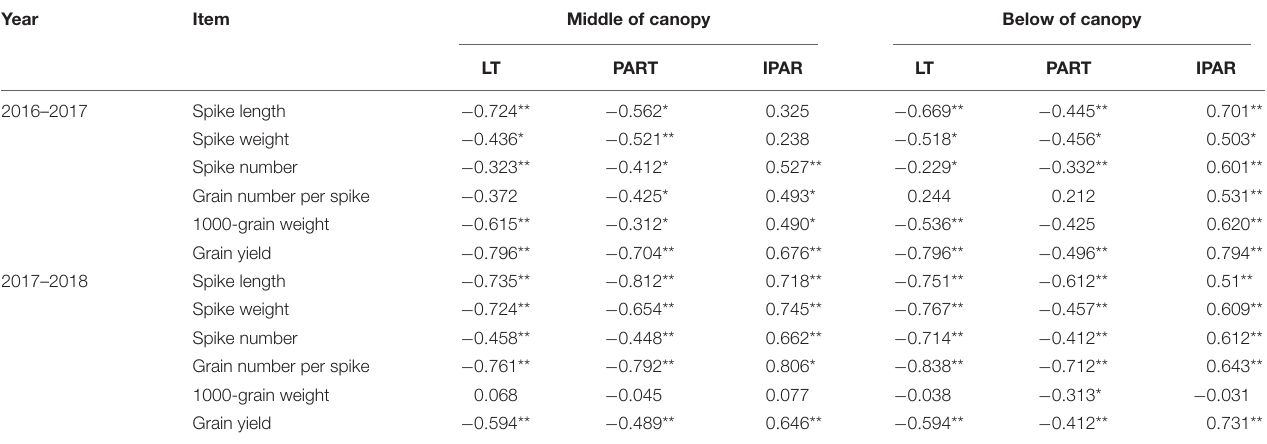
TABLE 6 | Correlation analysis between canopy light levels and yield, and the yield components of